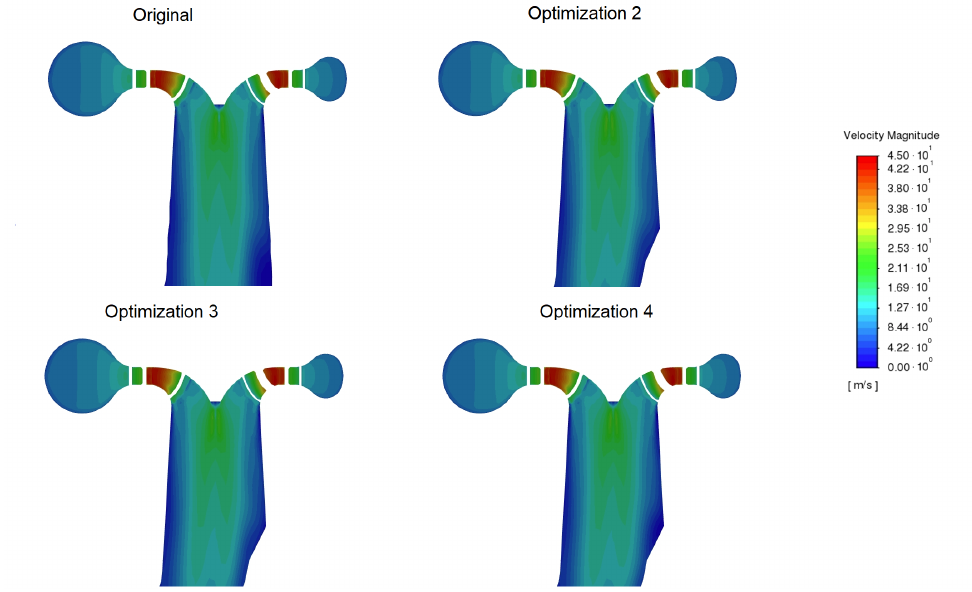
Figure A5. Detail of the velocity magnitude at the beginning of a draft tube for a 10 m 3 /s flow